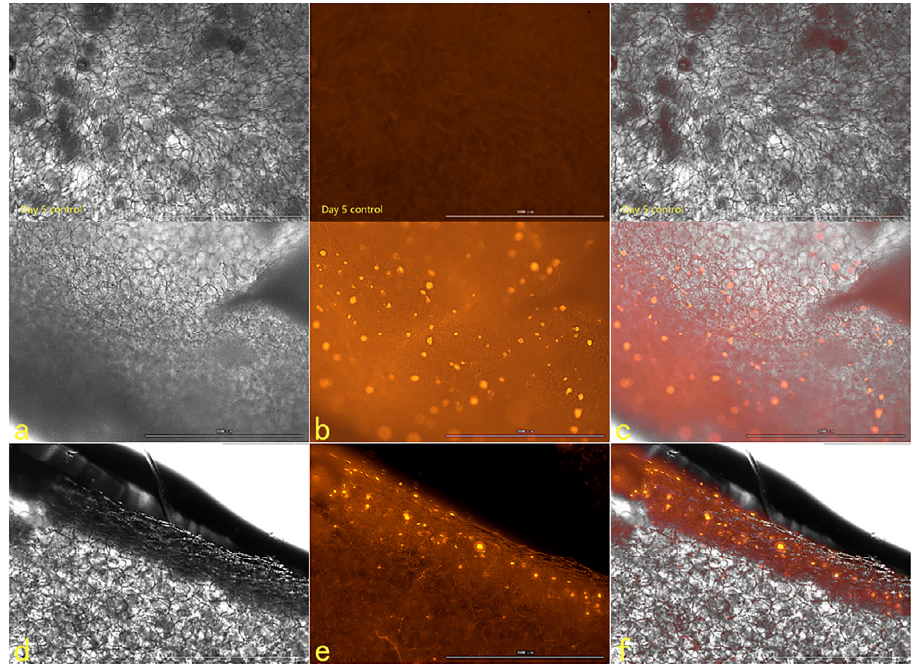
Figure 16. The HSFs detected on a three-dimensional scaffold, day 3. In the picture, ( a – c ) are the front of the stent, and ( d – f ) are the cross sections of the stent. ( a , d ) are bright fields, ( b , e ) are fluo- rescent fields, and ( c , f ) are composite pictures of bright fields and fluorescent fields. Control: only cell scaffolds and a culture medium containing AGQDs, no HSFs. Scale bars: 1000 μ m.